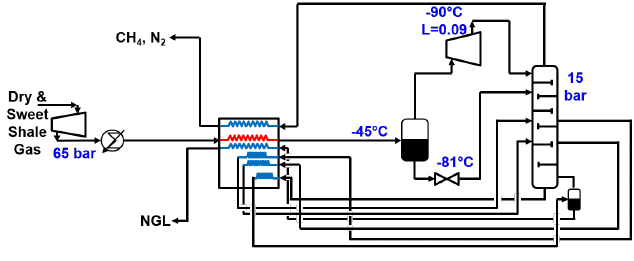
Figure A1. Turboexpander demethanizer scheme.